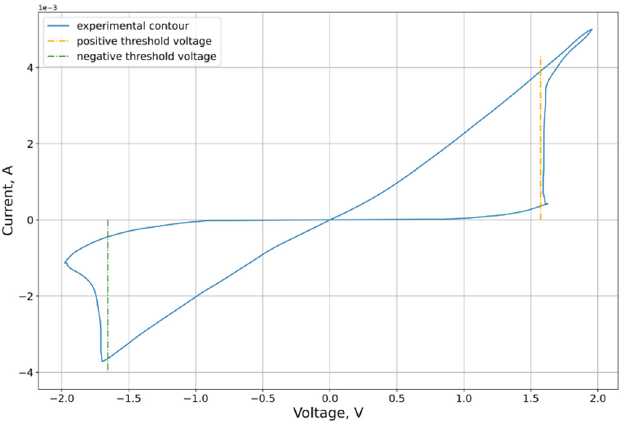
Figure 5. Approximated contour with marked threshold voltages.